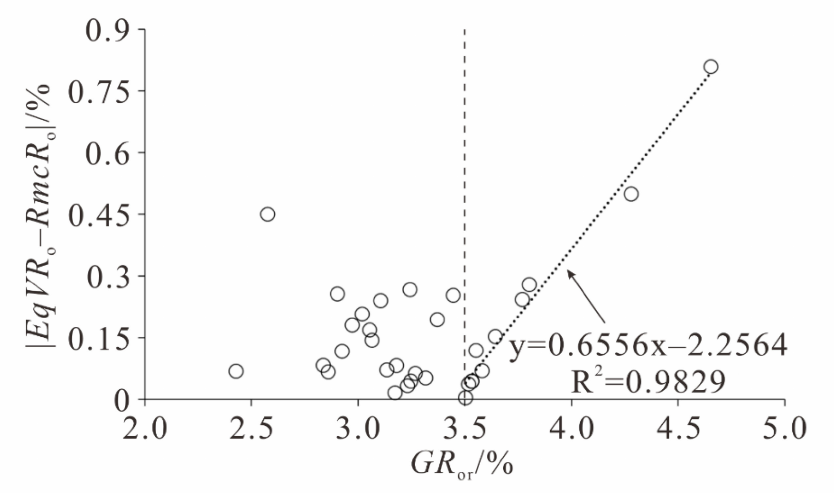
Figure 12. Analysis of the difference between EqVR o and RmcR o